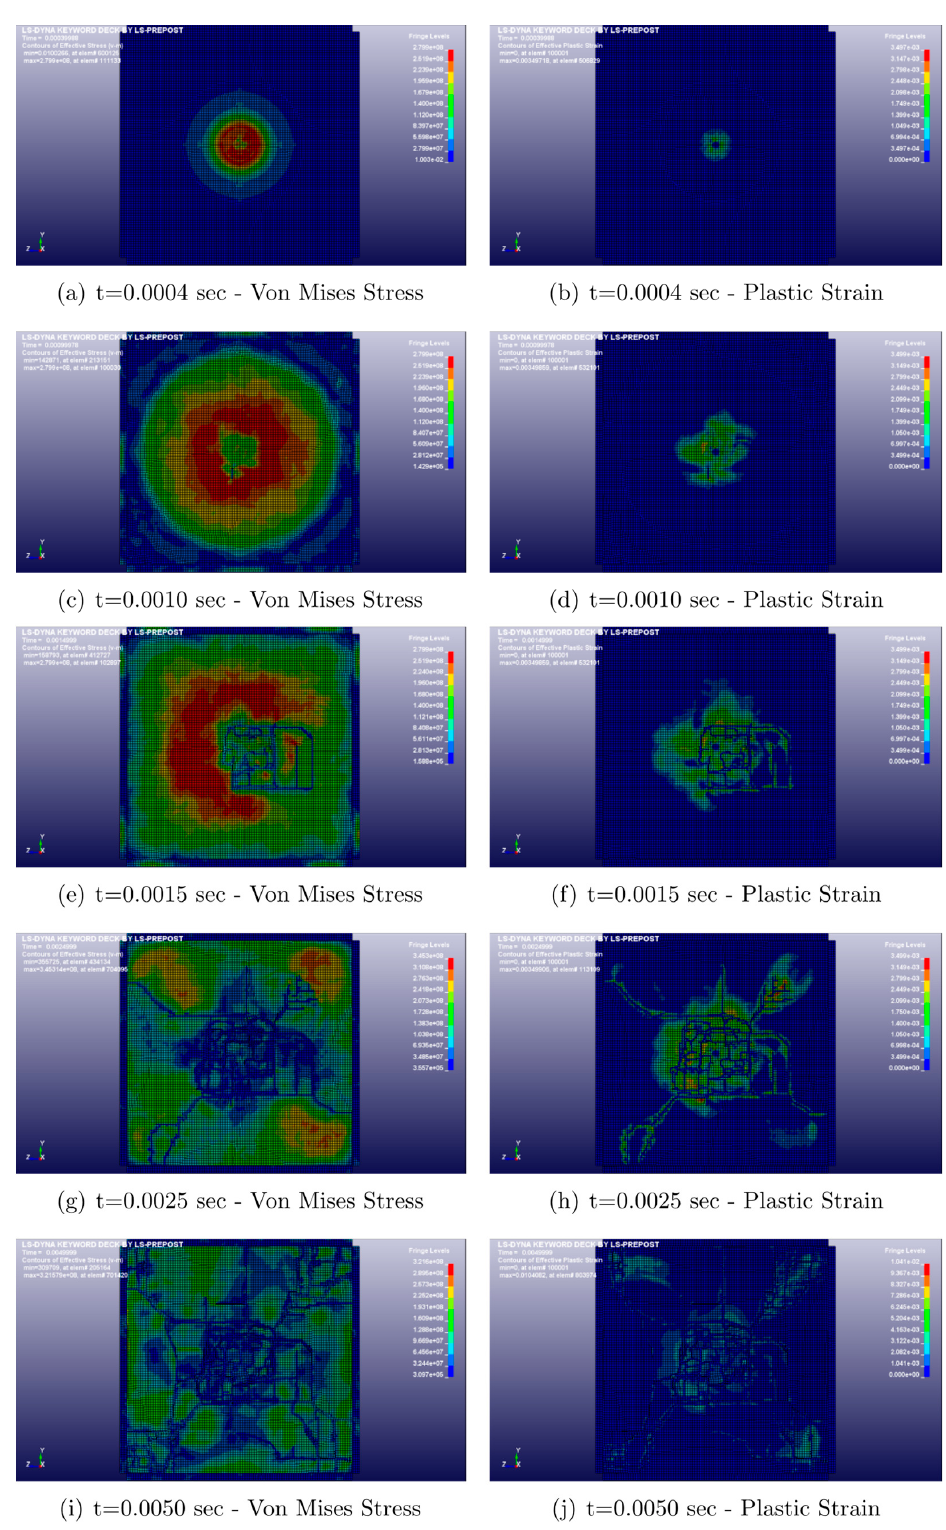
Figure 11. Von Mises stress and plastic strain.